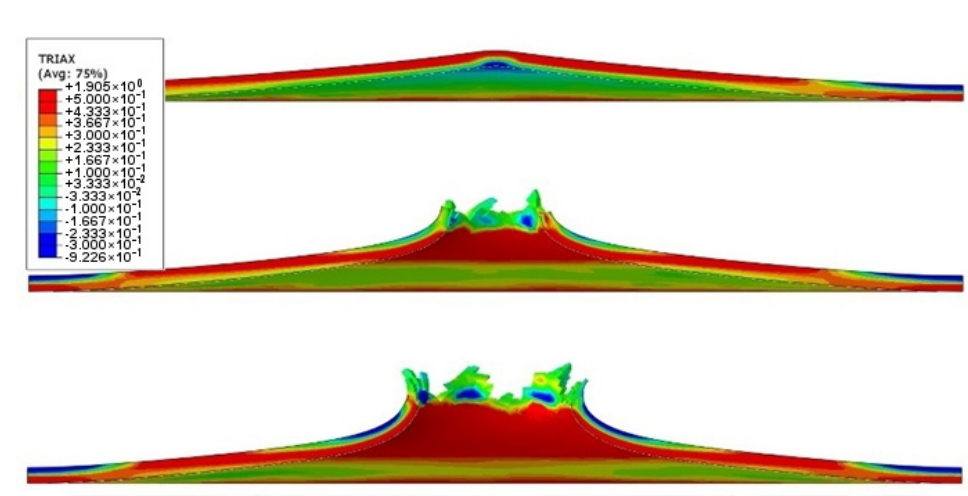
Figure 21. Stress triaxiality visualization in section view during puncture.